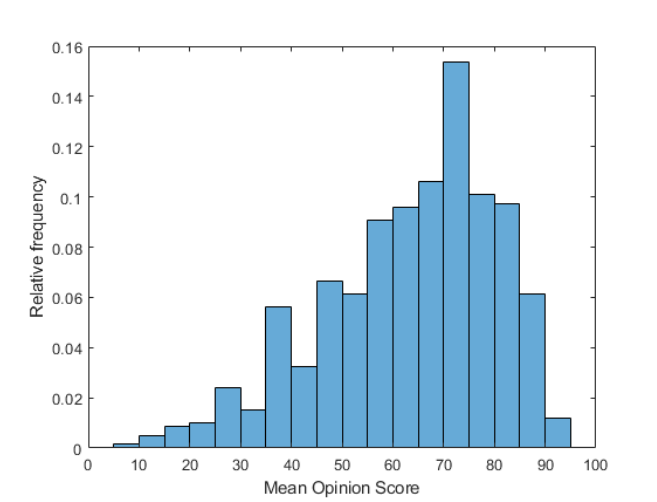
Figure 6. MOS distribution in LIVE VQC